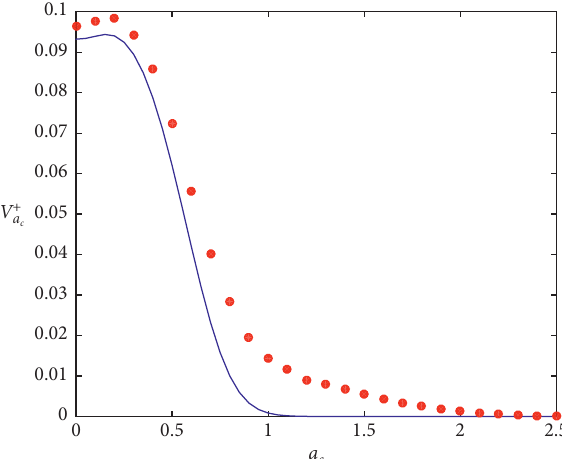
Figure 12: The mean up-crossing rate υ + excursion a c under α � 5 . 5 ( k results, and circles: MCS